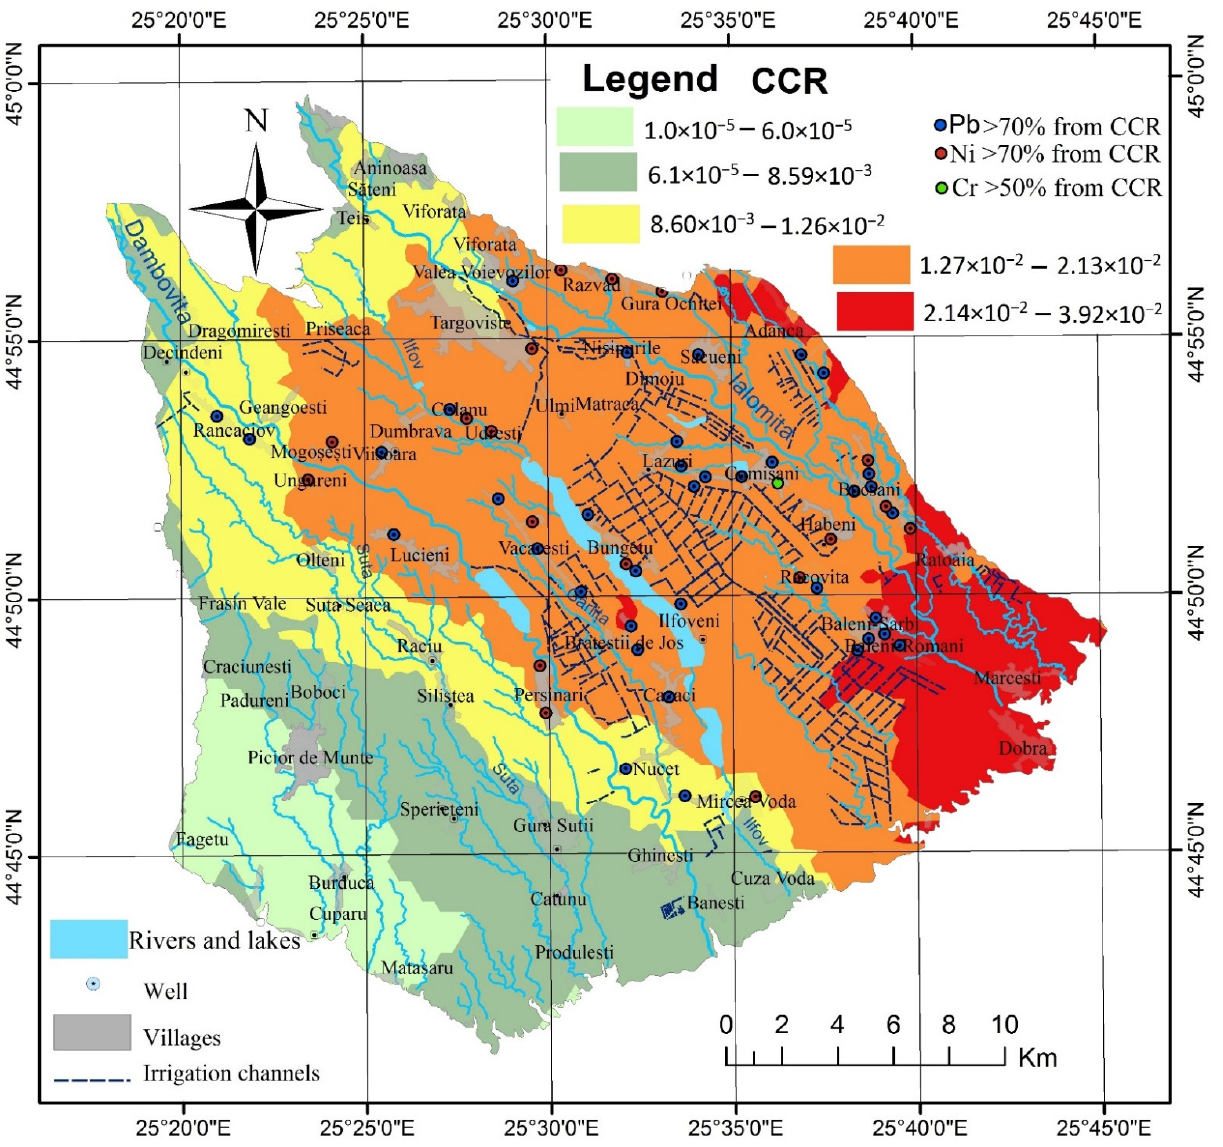
Figure 9. Spatial distribution of cumulative carcinogenic risk (CCR) in T â rgovi¸ste Plain. The high values, both individually for each carcinogen and in sum, indicate a very high risk of cancer occurrence during life for the population that consumes water from underground sources. The spatial distribution of CCR indicates extremely high values of risk in the villages of B ă leni, Buc¸sani, Br ă te¸stii de Jos, and Bungetu with risk rates of 2 to 4%. Almost 43% of the rural population in the T â rgovi¸ste Plain is in areas at risk > 1.12 × 10 − 2 , which, compared to the average value of CCR, represents a number of approximately 600 people likely to be diagnosed with cancer during their lifetime if they use groundwater as the main sources for drinking water. The risk of increased cancer incidence and mortality is accentuated by the fact that in 2016, out of the 43,643 homes in the villages of T â rgovi¸ste Plain, 41.8% had a water supply connected to a public network, 33.6% had their own water source (fountain, spring), and 24.53% of the houses did not have water supply installations. Under these conditions, 2400 homes do not have access to a verified water source, so approximately 68,000 residents are at risk. The spatial distribution of these dwellings related to the distribution of IwWQI, THI and CCR shows that 12,380 dwellings and approximately 33,426 inhabitants are in villages with poor groundwater quality and a high risk of developing various health